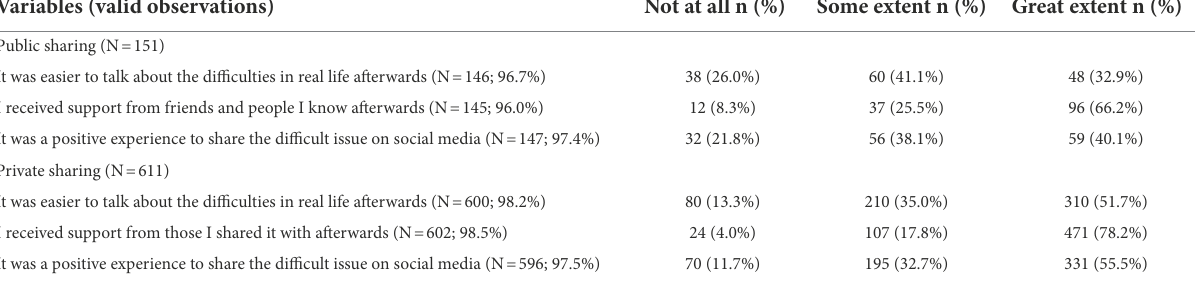
TABLE 2 Frequency distribution of responses on the three statements after answering “Yes” on the two questions about sharing something difficult. Variables (valid